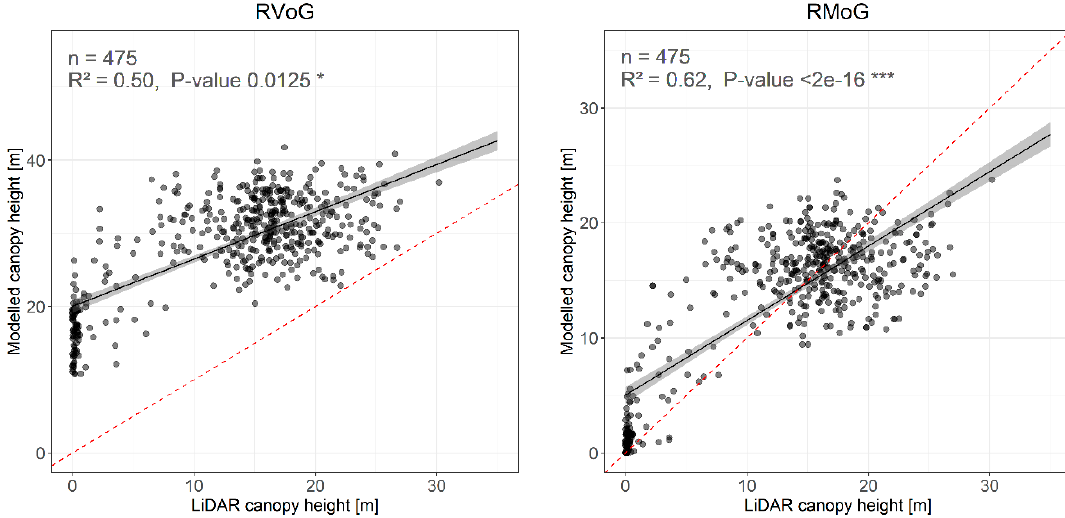
Figure 3. Correlation of reference LiDAR canopy height and modelled RS-2 canopy height for the RVoG (left) and RMoG (right) based on an interferogram from 27.09.-21.10. Dashed line = 1:1 line.